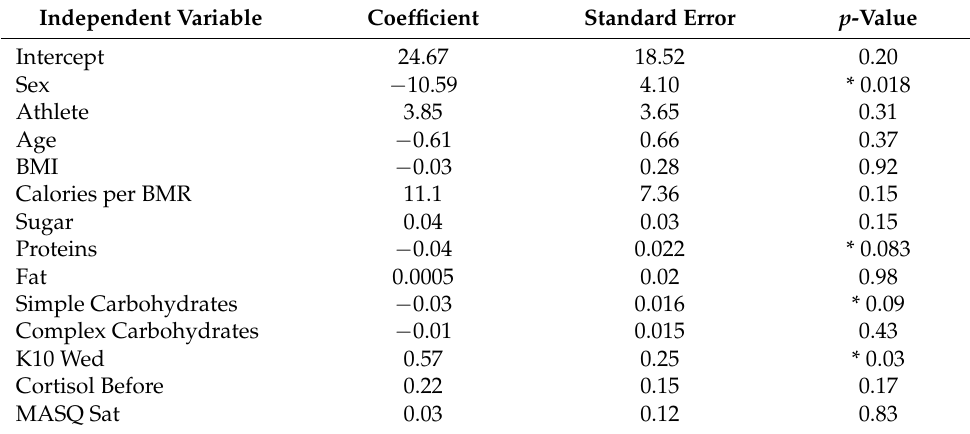
Table 11. Regression result of K10 Saturday scores (dependent variable) and sex, age, BMI, athlete, calories per BMR, cortisol level before exercise, MASQ scores on Saturday, K10 scores on Wednesday, sugar, proteins, fat, simple carbohydrates, and complex carbohydrates (independent variables). * p < 0.1.